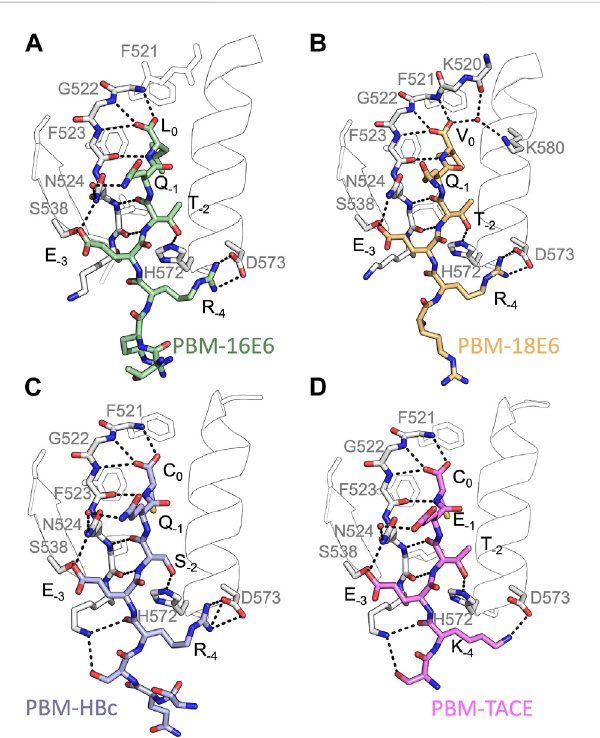
FIGURE 2 Insights of the binding network of PTPN3-PDZ with the PBM peptides of HPV16 E6, HPV18 E6, HBc and TACE. Secondary structure elements of PTPN3-PDZ are shown in white trace, and relevant residues are shown in white sticks. Peptides are shown as coloured sticks, with the corresponding name indicated below the structure. Polar interactions are shown as black